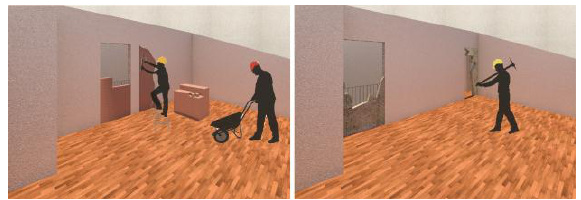
Figure 3. The variant represented the creation of two new doors and the closing of the existing ones by means of unstitch and